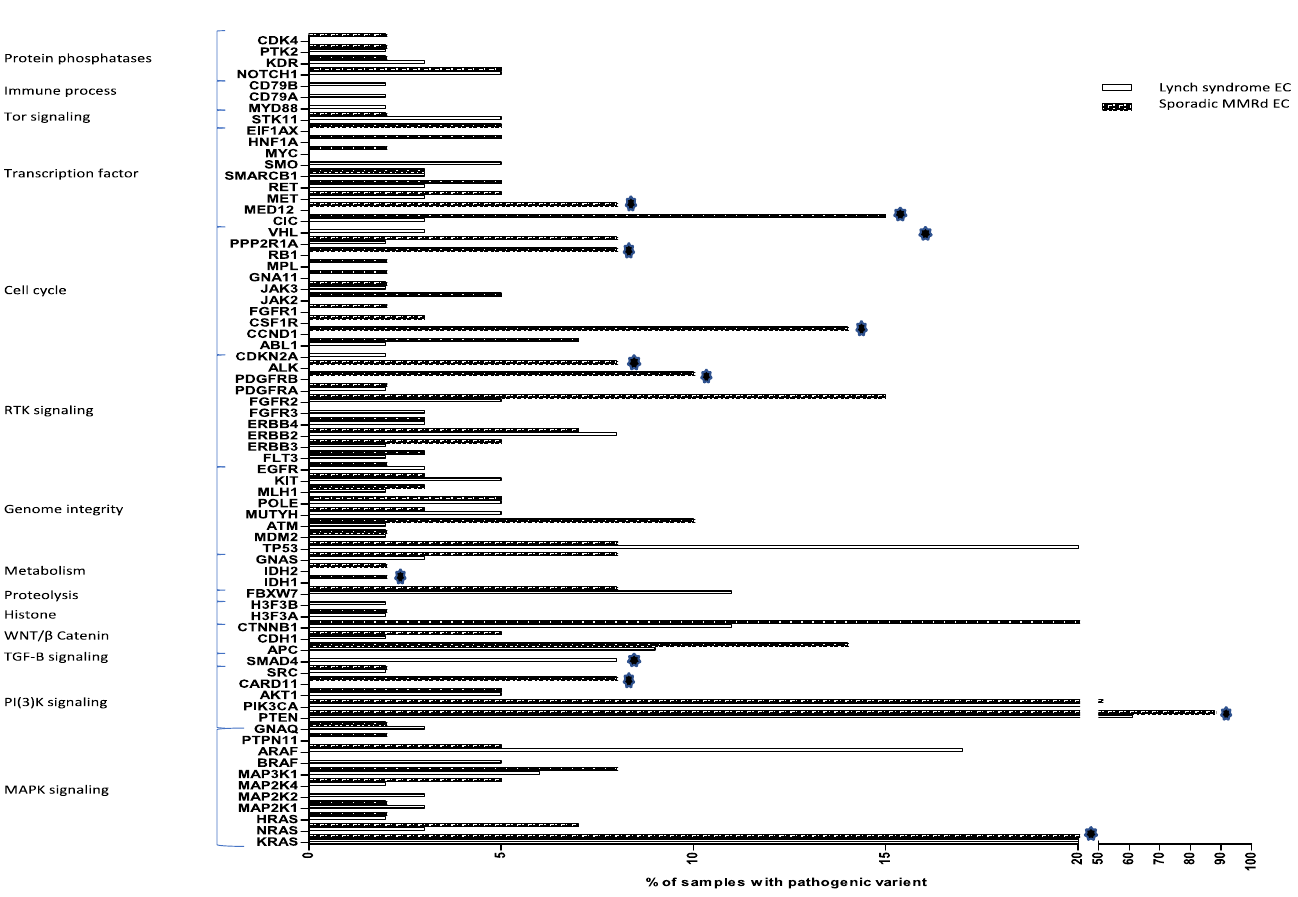
Figure 2. Mutational profiles of LS-EC and sporadic MMRd EC. The 75 genes included in the analysis are listed on the Y-axis grouped by associated cellular process. On the X-axis, the % of tumours with a pathogenic variant in analysed genes is demonstrated. Stars indicate genes in which the proportion of pathogenic variants between sporadic MMRd and LS-EC was significantly different.